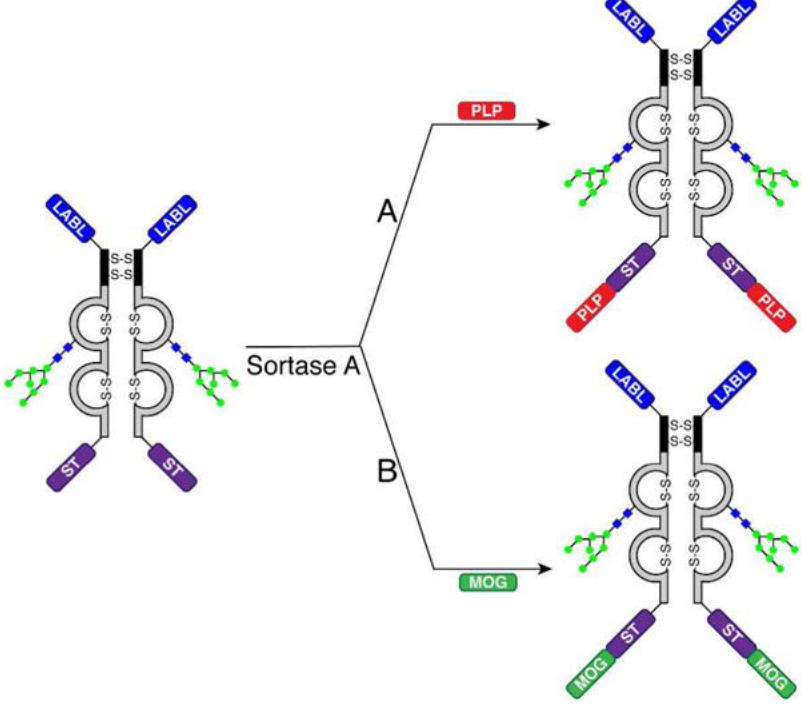
Figure 6. Sortase-mediated addition of two di ff erent antigens (A) PLP and (B) MOG to the C-terminus of LABL-Fc-ST (with permission of [109]).